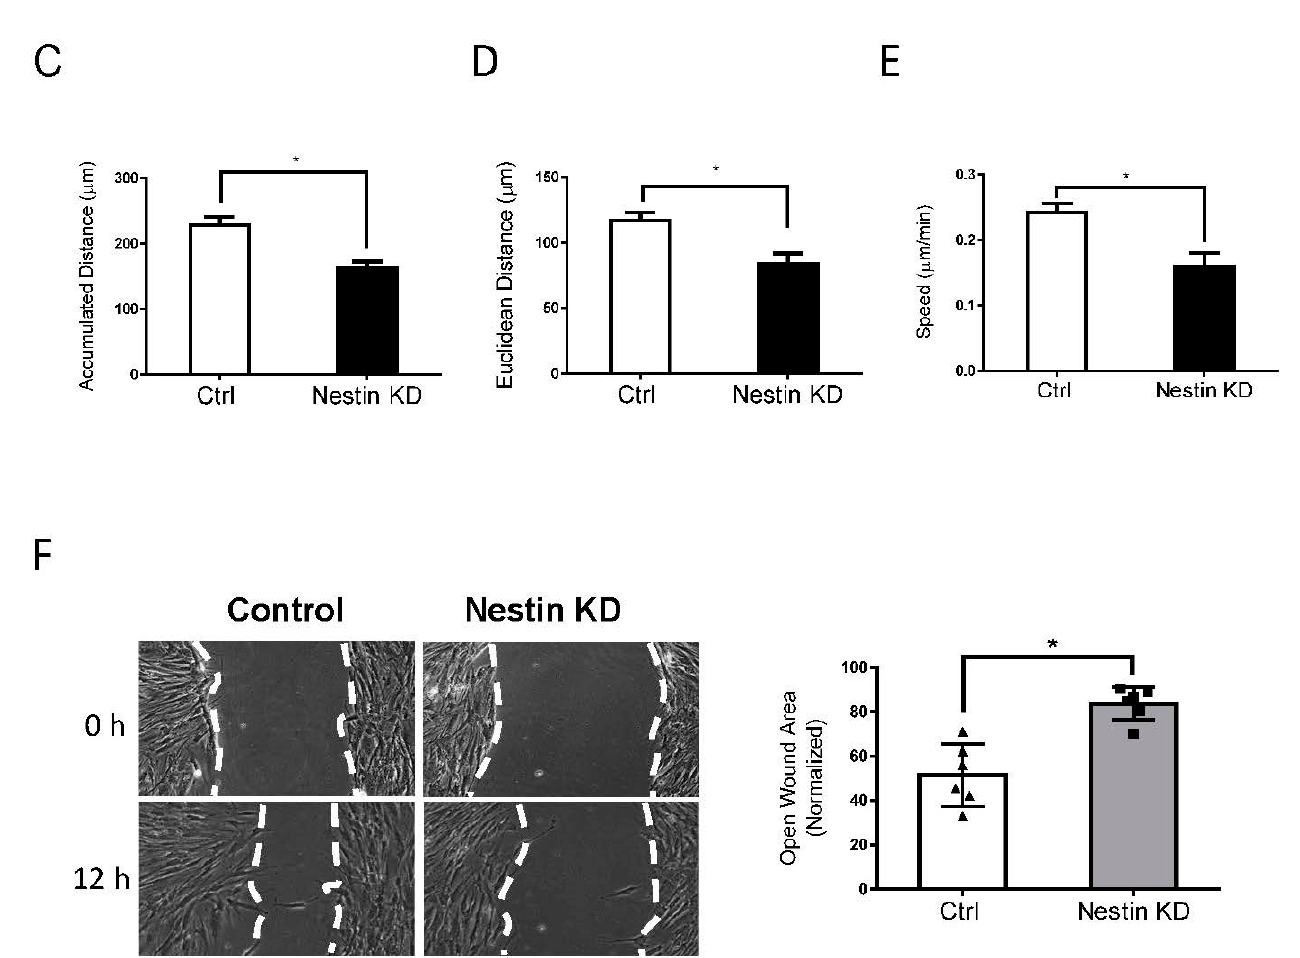
Figure 1. Knockdown (KD) of nestin reduces human ASM cell migration. ( A ) Protein expression of human ASM cells stably expressing control (Ctrl) shRNA or nestin shRNA was evaluated by immunoblotting. Data are mean values of experiments from 4 batches of cell culture. Error bars indicate SE. ( B ) Cell migration was tracked using a time-lapse microscope. Images were taken every 10 min for 12 h. Migration plots (32 cells from each group) were generated using the NIH ImageJ software. Red tracks indicate downward migration whereas black tracks indicate upward migration. ( C – E ) Nestin (Nes) KD reduced accumulated distance, Euclidean distance, and speed of cell migration. ( F ) Nestin KD inhibits the migration of human ASM cells as evidenced by the wound healing assay, which was described in detail in Material and Methods. Data are mean values of six experiments. Error bars indicate SE. * p < 0.05. t -test was used for statistical